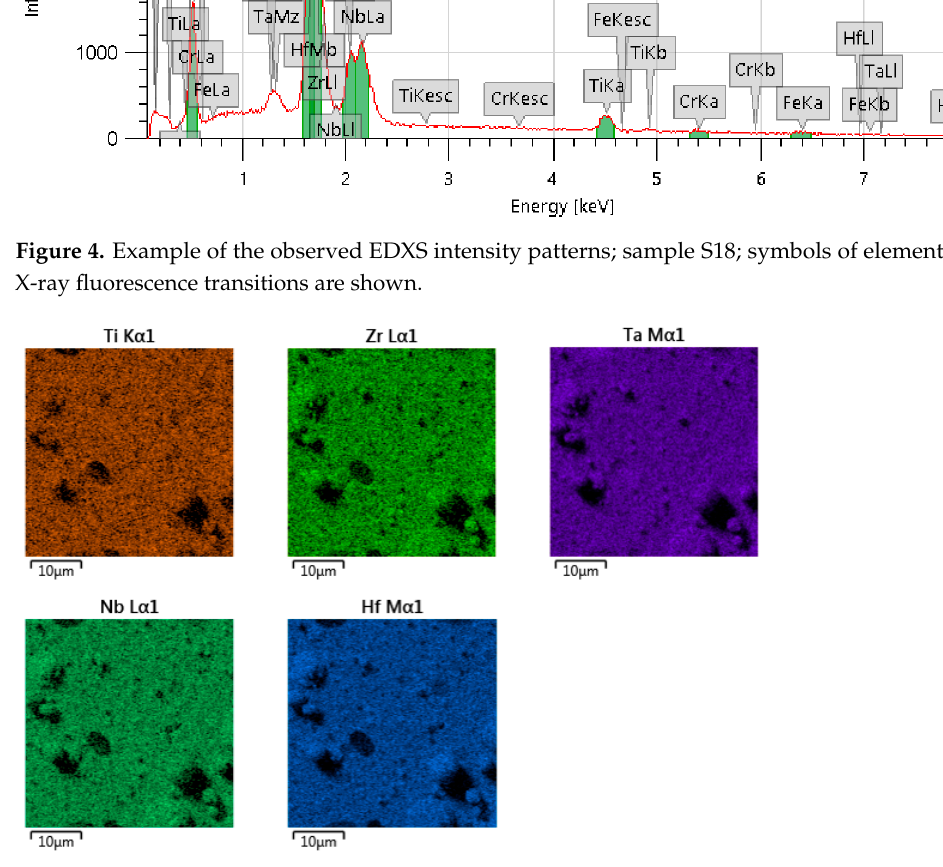
Figure 5. Example of the elemental surface concentration maps obtained by EDXS; sample S18; symbols of the elements and characteristic X-ray fluorescence lines used in the measurements are shown.